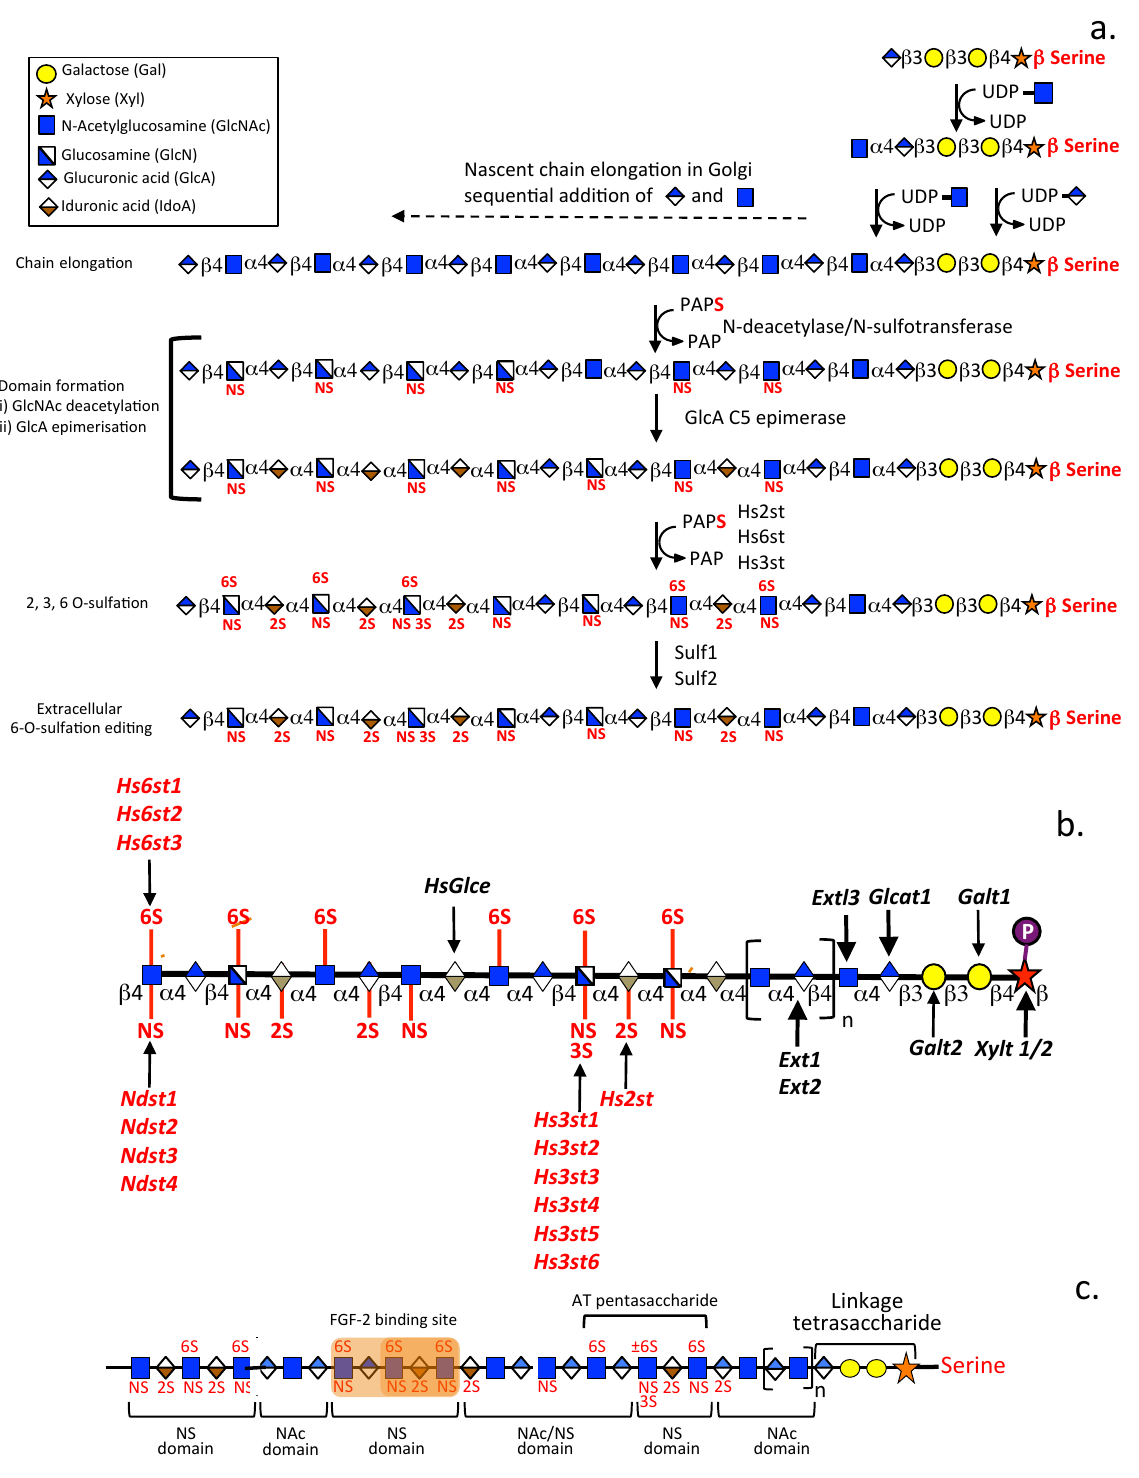
Figure 1. The multiple steps in the biosynthesis of putative heparin and HS chains ( a ), and the multiple enzymes that sulfate specific regions ( b ) and identification of specific HS sequences and sulfate presentations that provide FGF-2 and AT binding sites in a putative HS chain ( c ). Figure reprinted/adapted from Suflita M et al. [22] with the permission of Springer publishers. The GAG symbols used in this figure are those recommended by the symbol nomenclature for glycans (SNFG) discussion group